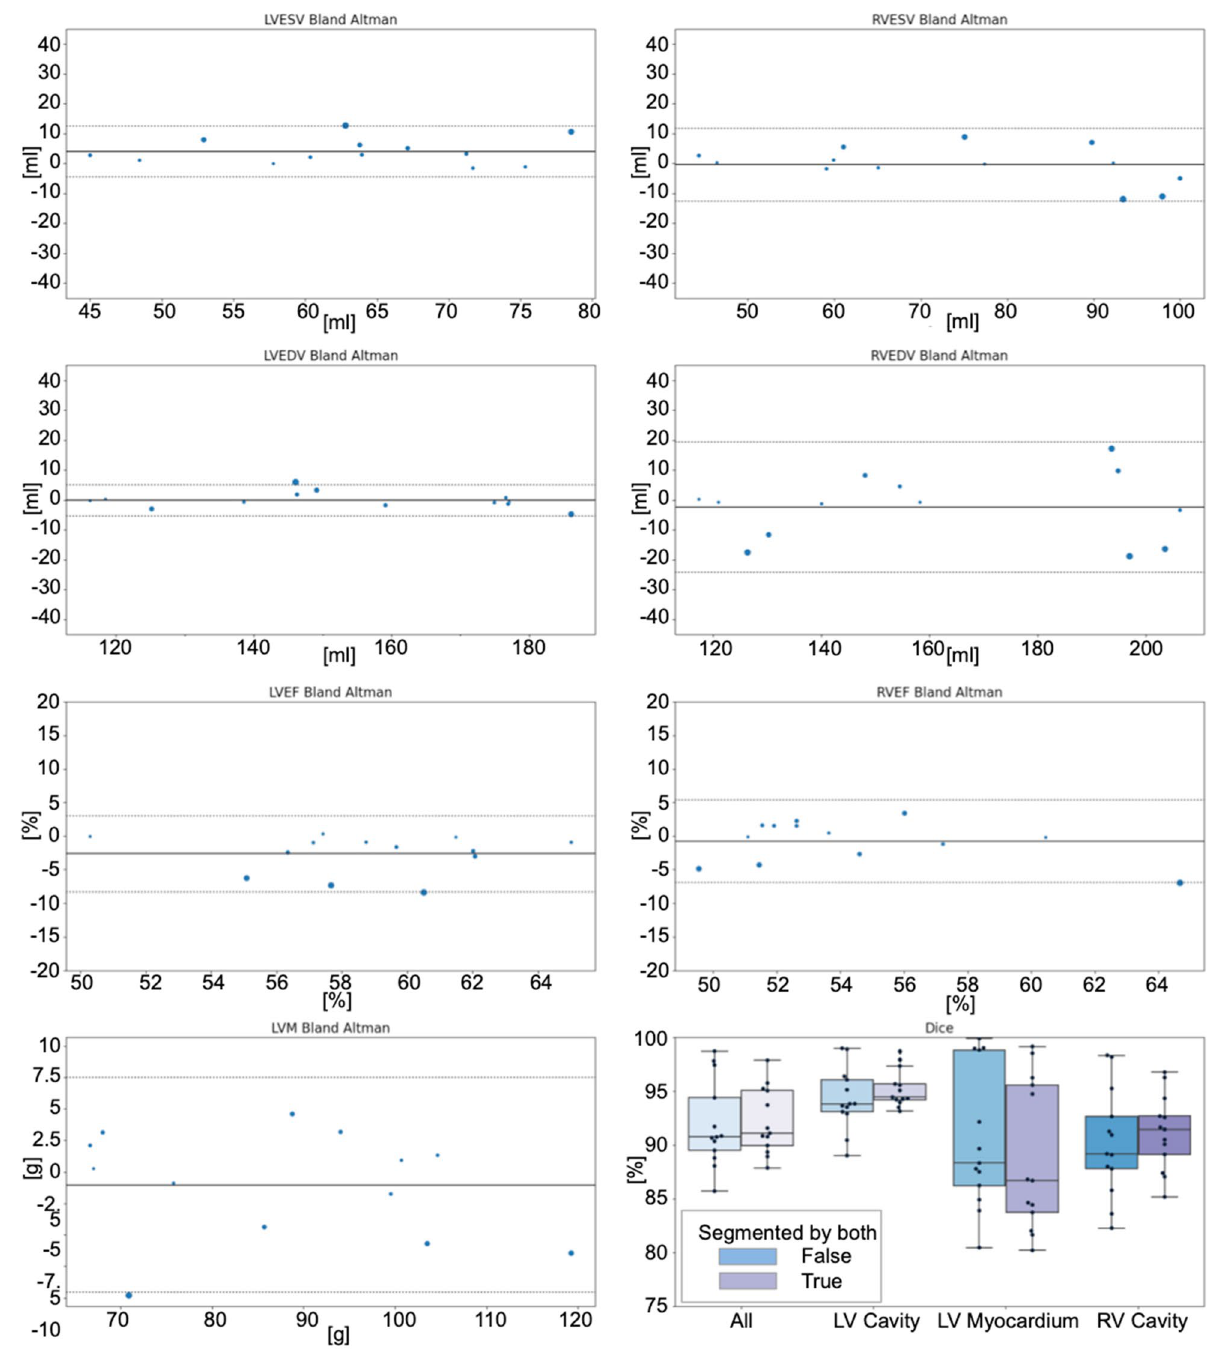
Figure 2. Automatic Generation of Clinical Results Overview. Caption: This plot is automatically generating after loading the cases into Lazy Luna’s GUI. Bland-Altman plots show clinical result averages and differences as points for all cases. Point size represents difference size. The solid line marks the mean difference between readers; the dashed lines mark the mean differences ±1.96 standard deviations. The last plot offers two Dice boxplots per contour type, one for all images, another restricted to images segmented by both readers. The clinical result differences hover around zero for the LV and the RV. The variance is larger for results concerning the RV. Dice values are higher for the LV cavity than for LV myocardium or RV cavity. GUI: Graphical user interface, RV: Right ventricle, LV: Left ventricle, ESV: End-systolic volume, EDV: End-diastolic volume, EF: Ejection fraction, LVM: Left ventricular mass, Dice: Dice similarity